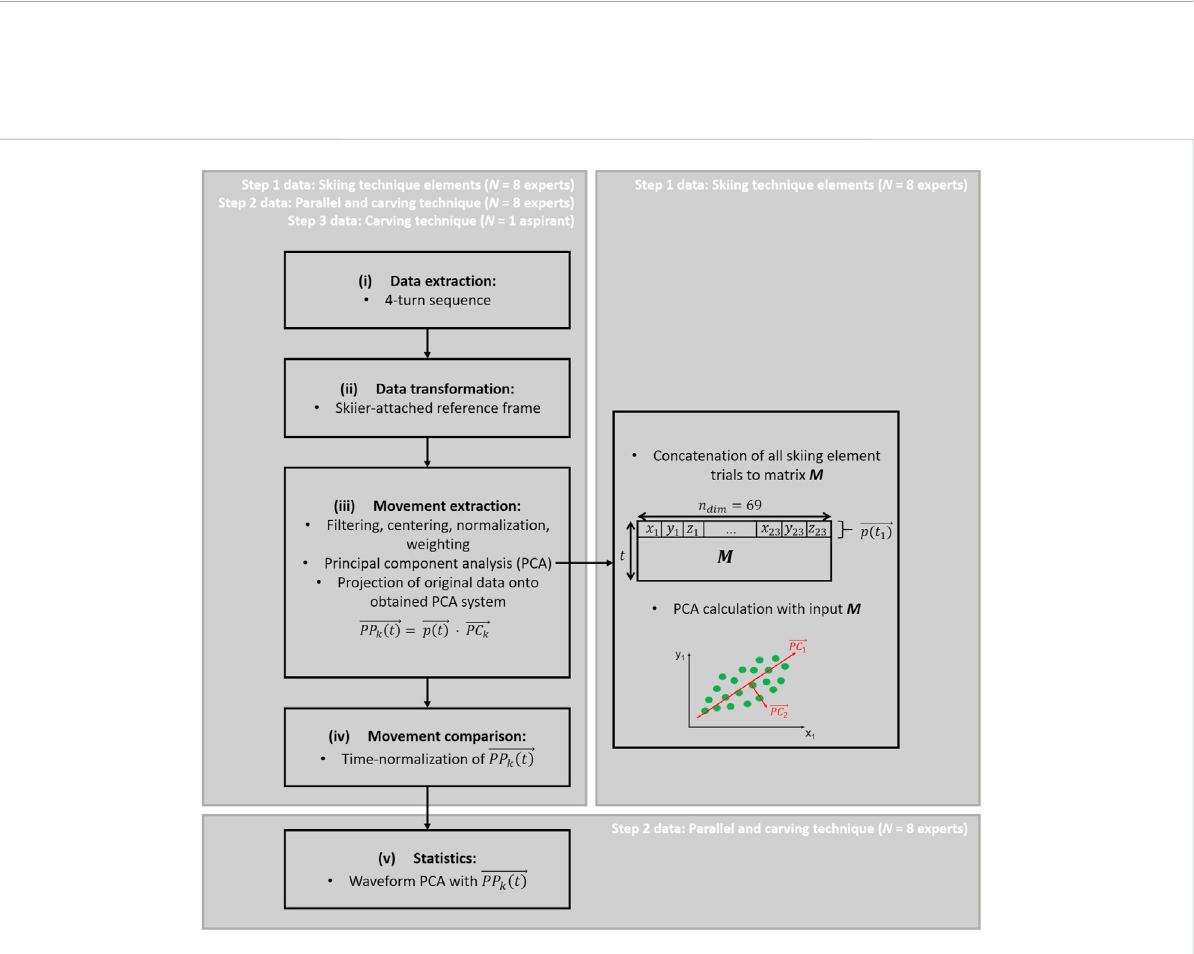
FIGURE 3 Flowchart of data analysis steps from data extraction of four consecutive turns, to transformation into skier-attached reference frame, movement extraction by principal component analysis (PCA), comparison through time-normalization and statistical evaluation. The PCA is performed for theskiing techniqueelementtrials (step 1 data) and the skiing technique trials (step 2 and 3data) are projected onto the obtained PCA